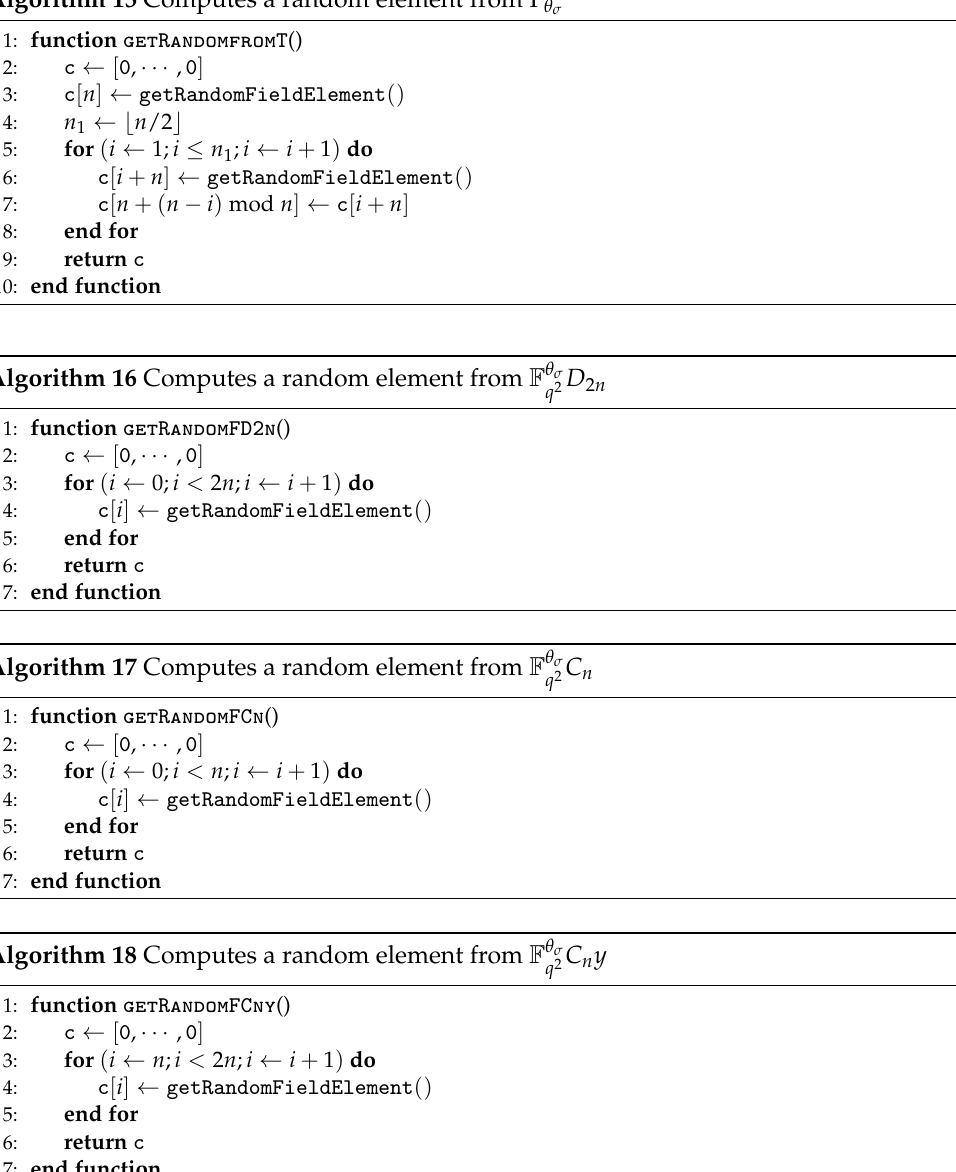
Algorithm 15 Computes a random element from Γ θ